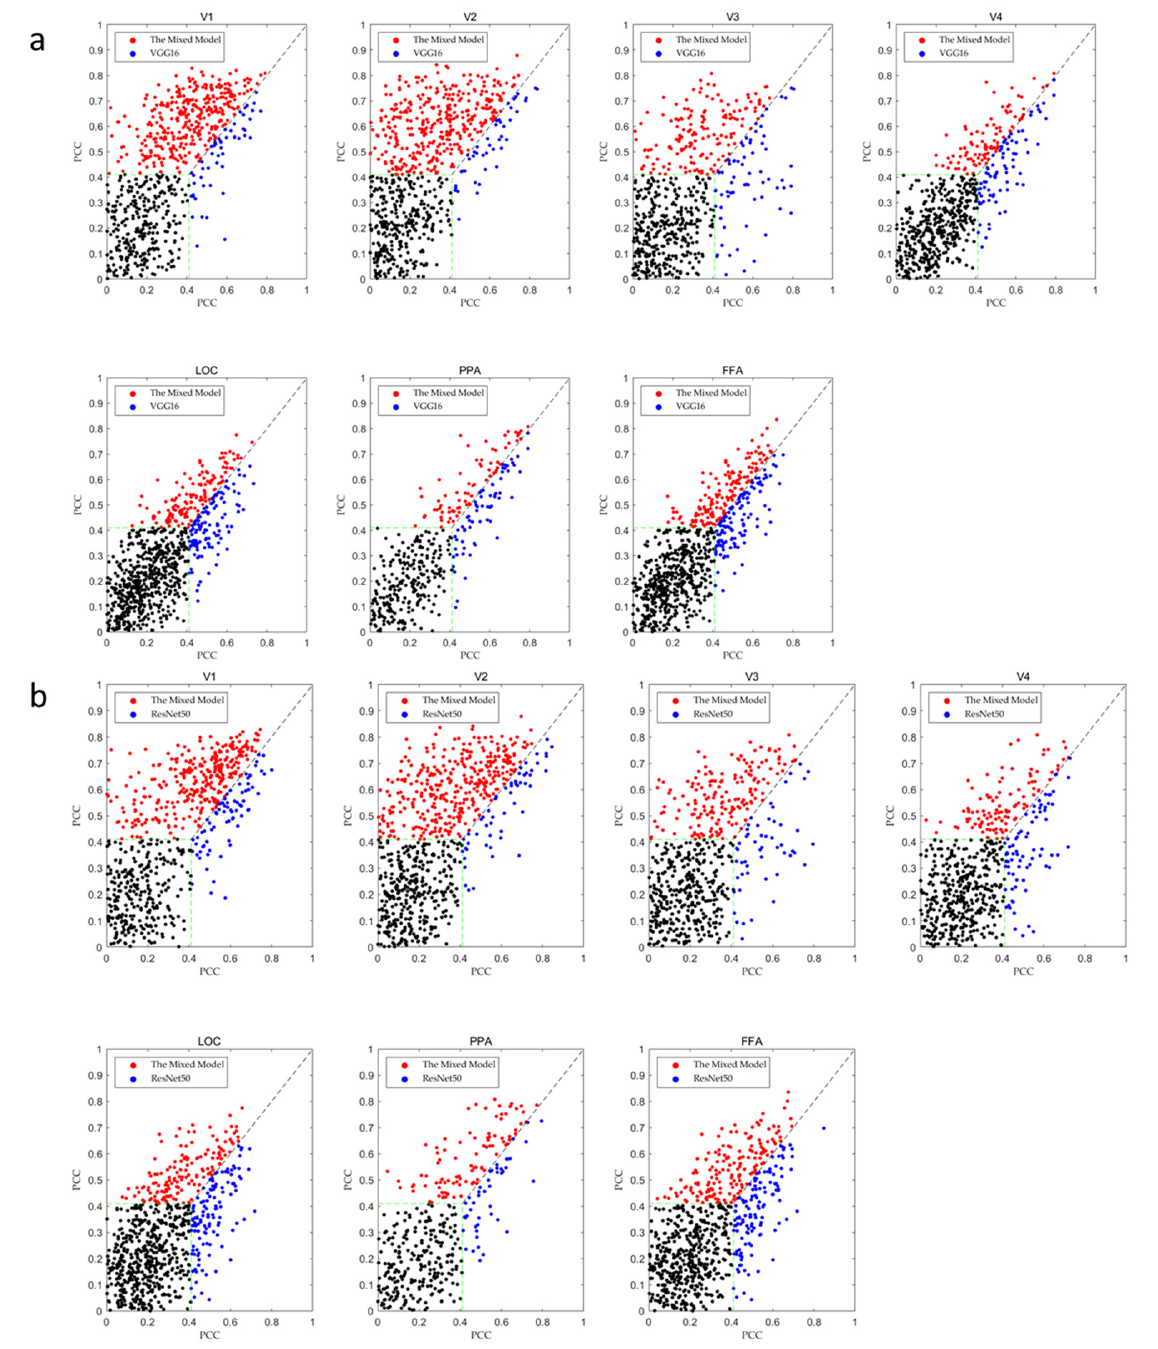
Figure 3. ( a ) Comparison of the encoding performance between the mixed model and VGG16. ( b ) Comparison of the encoding performance between the mixed model and ResNet50. The horizontal and vertical axes in the scatterplot represent the correlation values of the voxels predicted by the traditional convolution model and the correlation values of the voxels predicted by the mixed model, respectively. The red points represent the points at which the correlation of the voxels predicted by the mixed model is higher than the traditional model. The blue points represent the points at which the correlation of the voxels predicted by the traditional model is higher than that of the hybrid model. The black points represent the points at which the voxel correlation predicted by the two models cannot reach a valid value. The green line in the scatterplot represents the threshold for valid predicted voxels (i.e.,